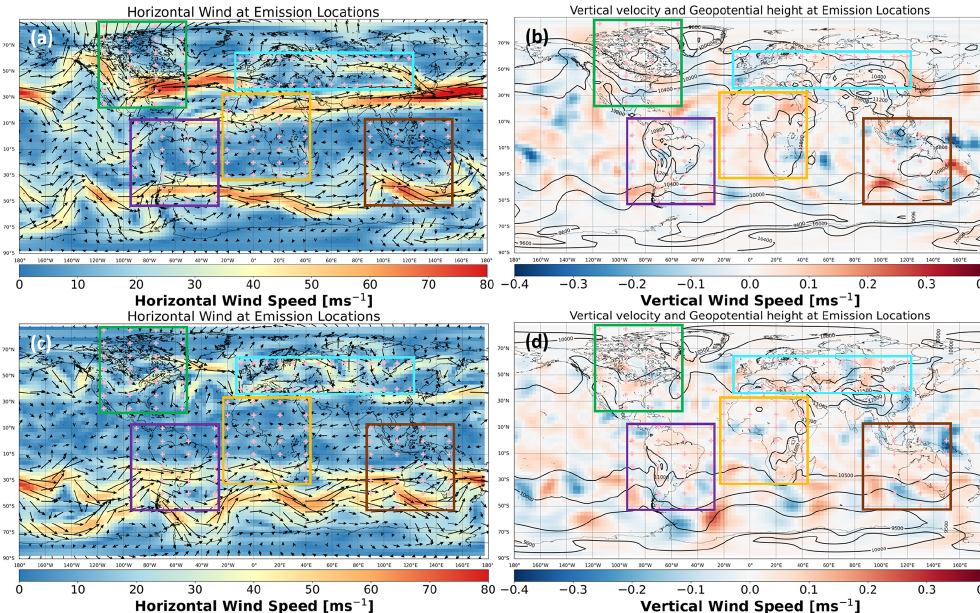
Figure C1. Averaged horizontal and vertical wind fields at ∼ 250hPa during January–March 2014 in panels (a) and (b) . Same information is portrayed in panels (c) and (d) for July–September. Geopotential height contours in Fig. C1b and C1d are expressed in meters. The same emission points as in Fig. 1 are shown with “ + ” in each